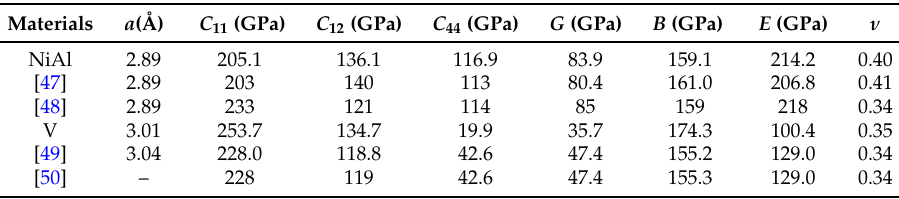
Table 1. Summary of the lattice constants a , elastic constants C 11 , C 12 , C 44 , shear modulus G , bulk modulus B , Young’s modulus E and Poisson’s ratio ν for NiAl and